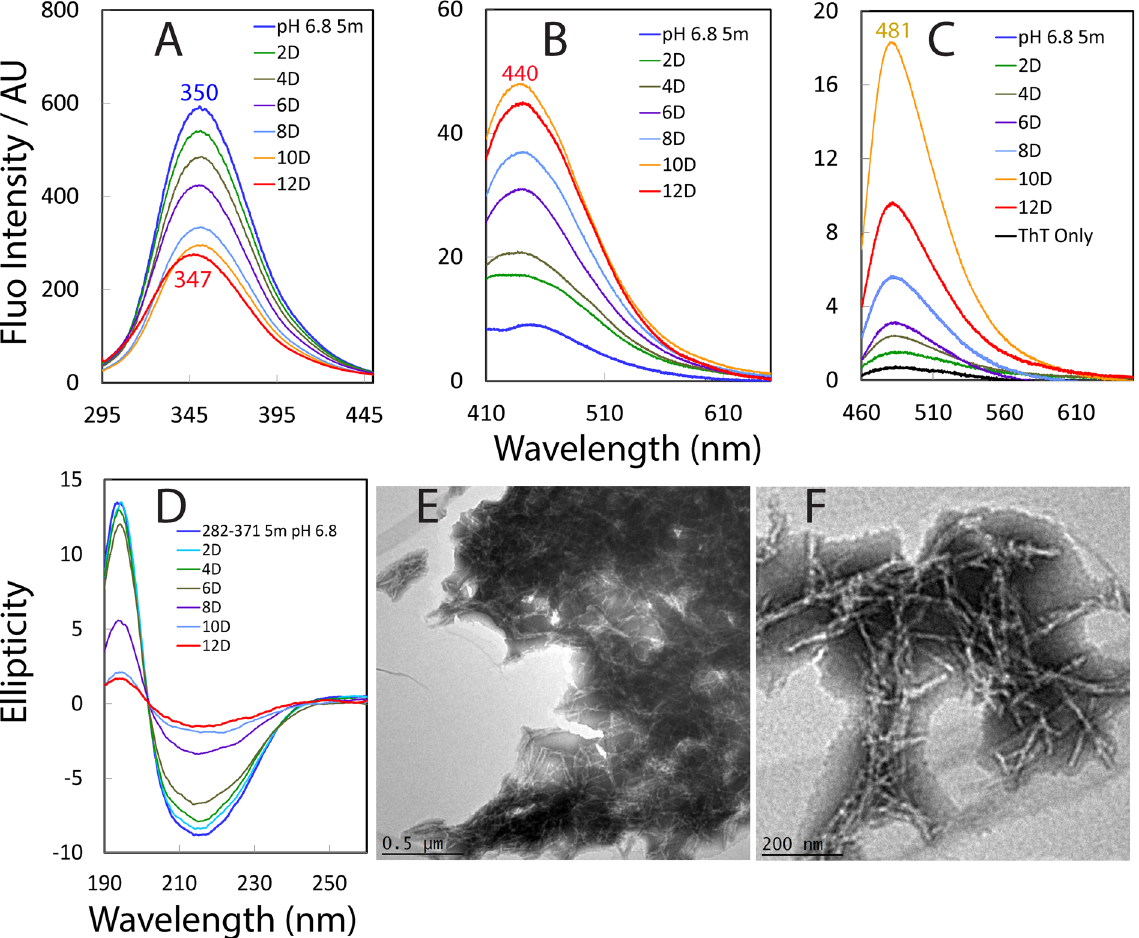
Figure 8. Spontaneous self-assembly of the FUS RRM domain. Emission spectra of the intrinsic UV ( A ); and visible fluorescence ( B ) of the FUS RRM domain at a protein concentration of 40 µ M in 1 mM phosphate buffers at pH 6.8 at different time points of the incubation at 25 °C. Wavelengths of the emission maxima are labelled. ( C ) Emission spectra of the ThT-binding induced fluorescence for the FUS RRM domain, which have the typical emission maximum at ~486 nm. ( D ) Far-UV CD spectra of the FUS RRM domain at a protein concentration of 40 µ M in 1 mM phosphate buffers at pH 6.8 at different time points of the incubation. EM images of the FUS RRM domain sample at the lower magnification (scale bar of 0.5 μ m) ( E ); and higher magnification (scale bar of 200 nm) after 10 days of the